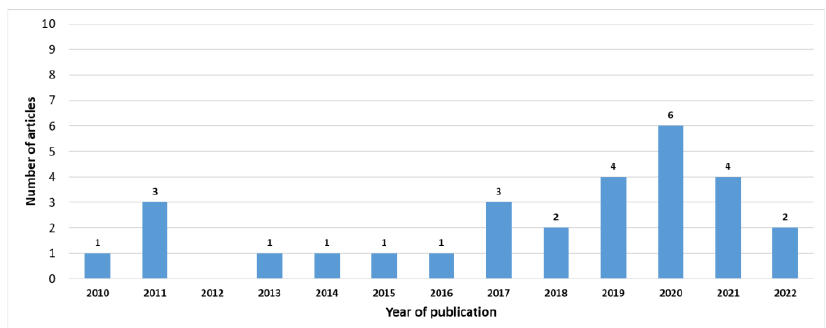
Figure 2. Annal publication trend of articles for design collaboration in ImVE.